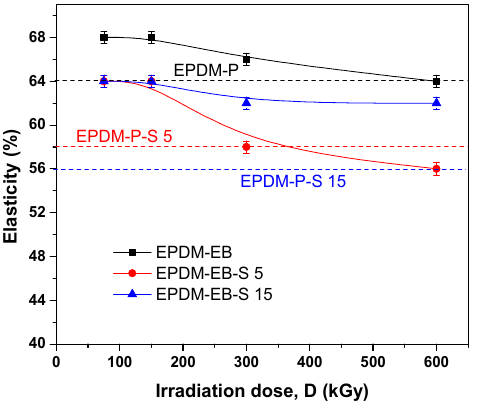
Figure 1. The influence of sawdust amount and the cross-linking method (P / EB) on composite hardness.